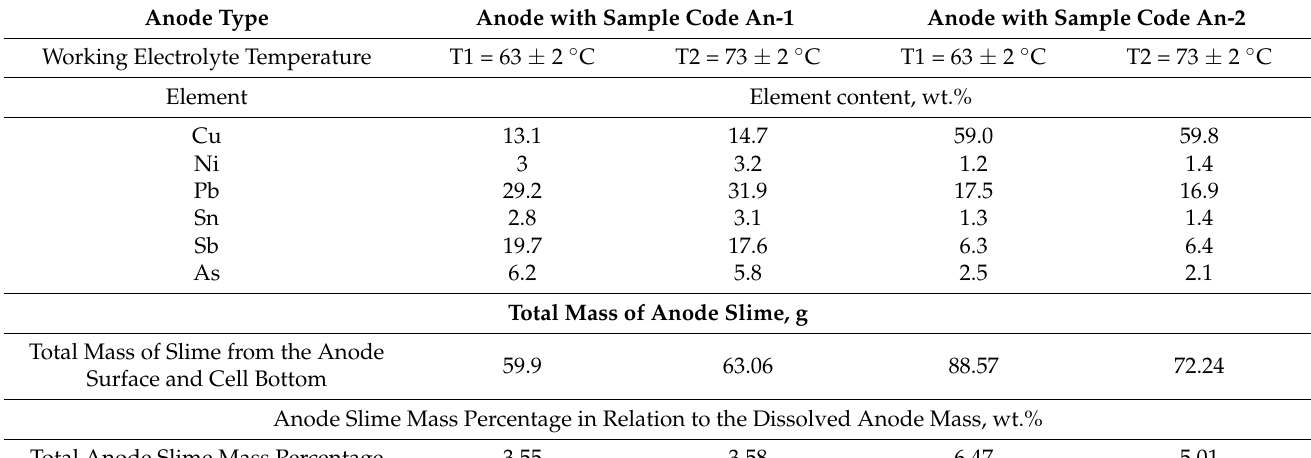
Table 4. Anode slime chemical composition, mass of anode slime, and anode slime mass percentage in relation to the dissolved anode